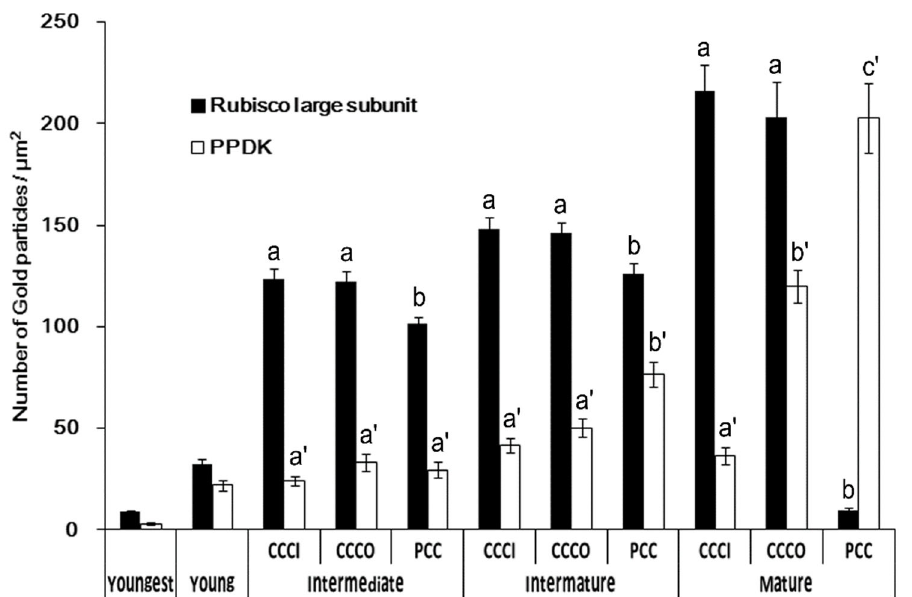
Figure 4. Quantification of RbcL and PPDK in chloroplasts in the developing leaves of B. sinuspersici based on immunolocalization analyses. The number of gold particles per unit area ( µ m 2 ) was determined for RbcL and PPDK in developing leaves for chloroplasts in 25 cells from three biological replicates. Mean ± SE. Different letters represent a significant difference (a and b for RbcL; a’, b’, and c’ for PPDK) using the Student t ‐ test ( p < 0.01). RbcL, Rubisco large subunit; CCC, central cytoplas ‐